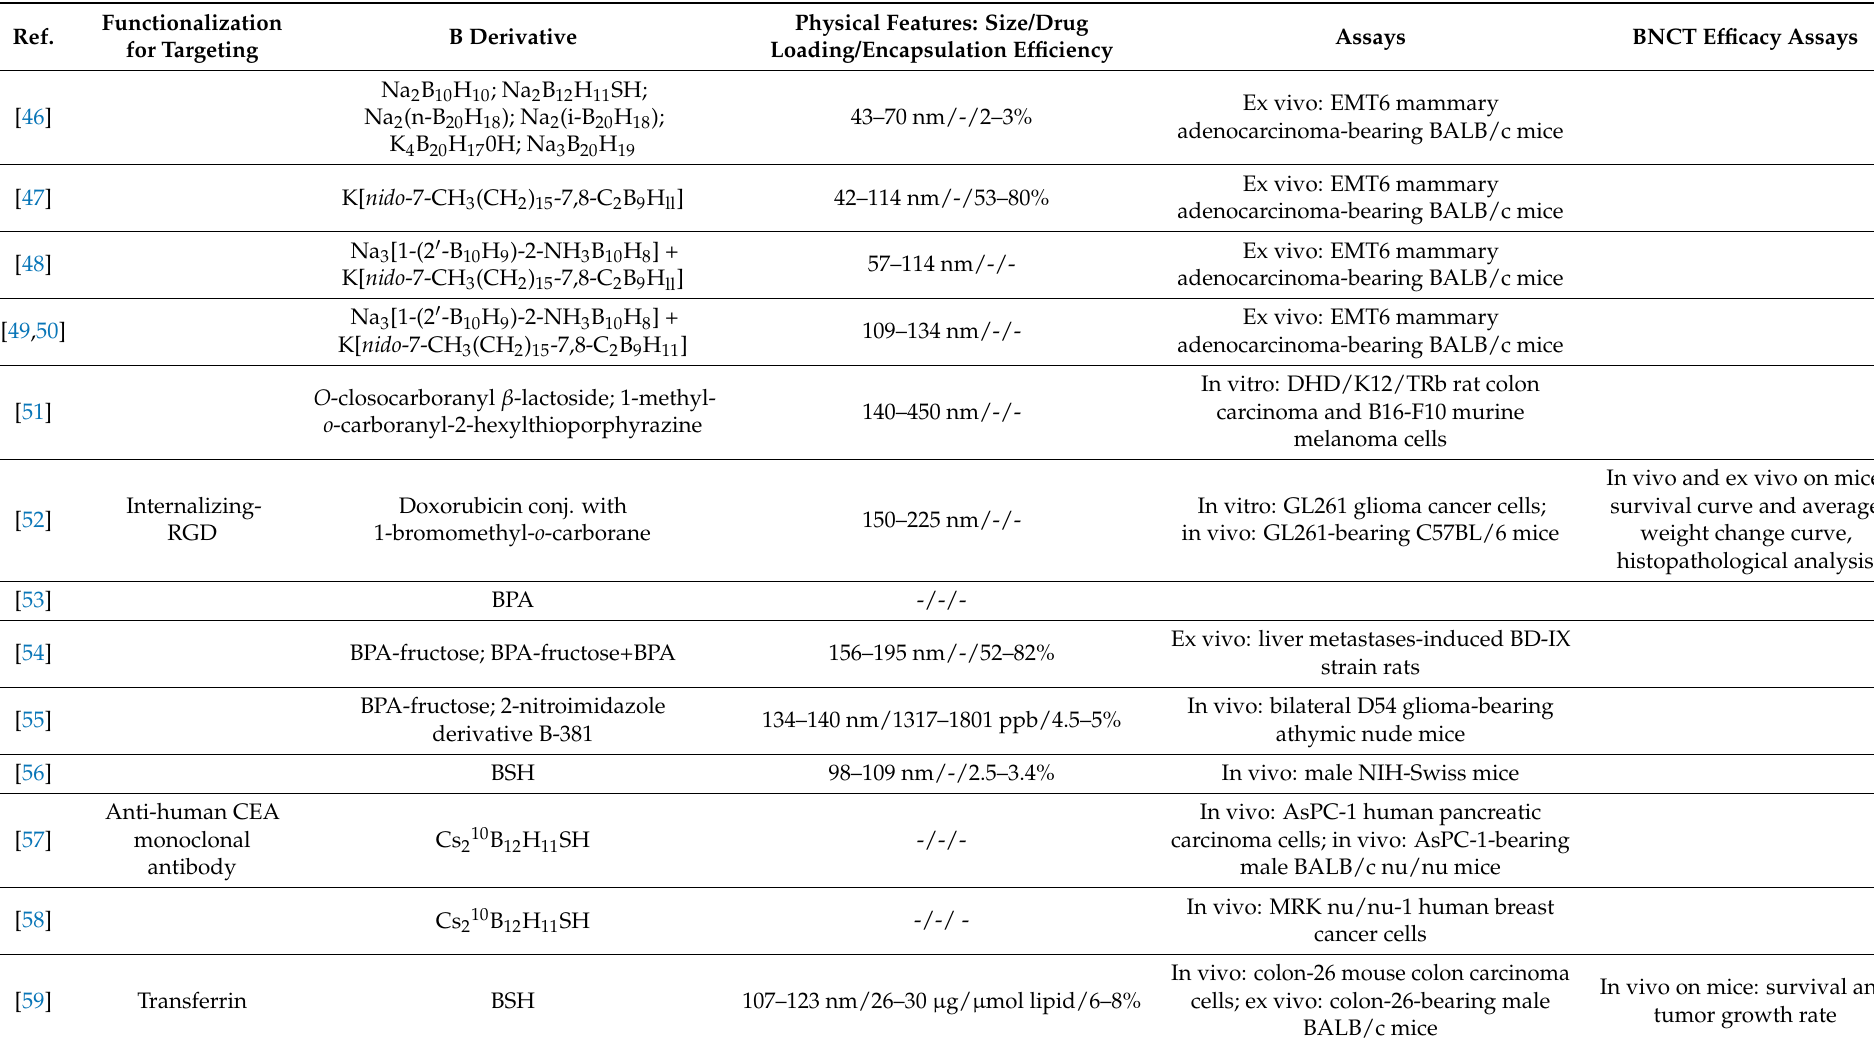
Table 1. Liposomal formulations for BNCT